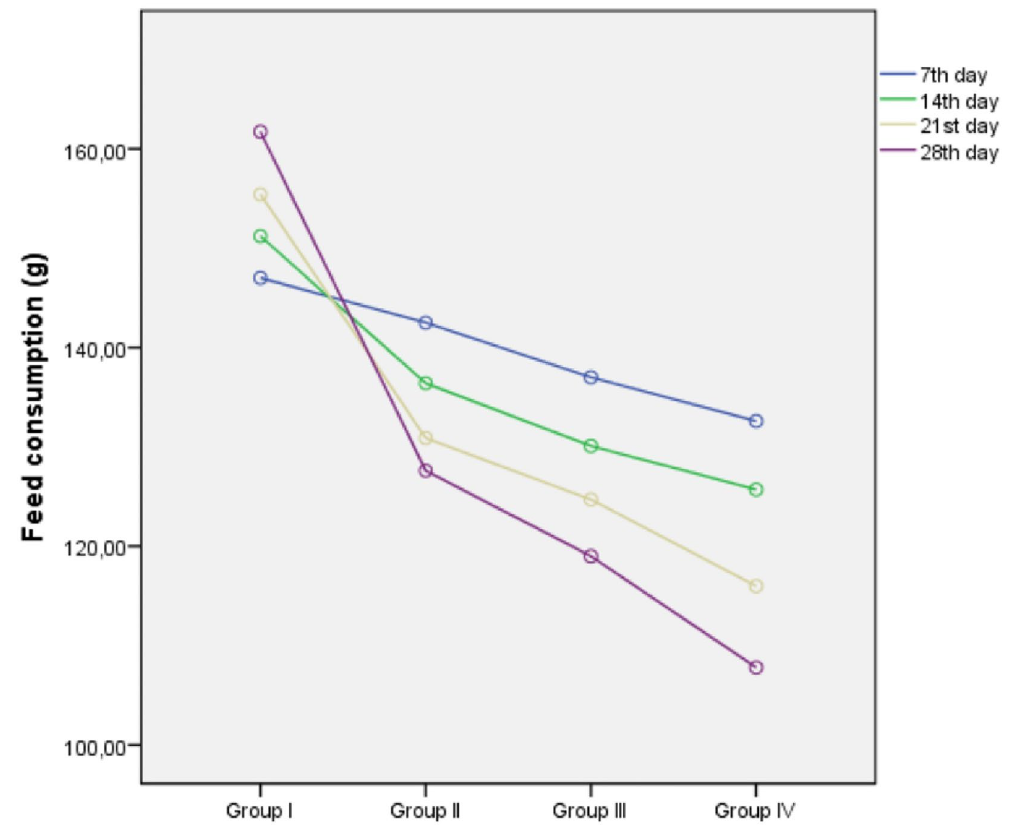
Figure 2. The effects of cypermethrin on weekly feed consumption of mice (g). *Group I: control, Group II: 62.5 mg/kg b.w cypermethrin, Group III: 125 mg/kg b.w cypermethrin, Group IV: 250 mg/kg b.w cypermethrin.